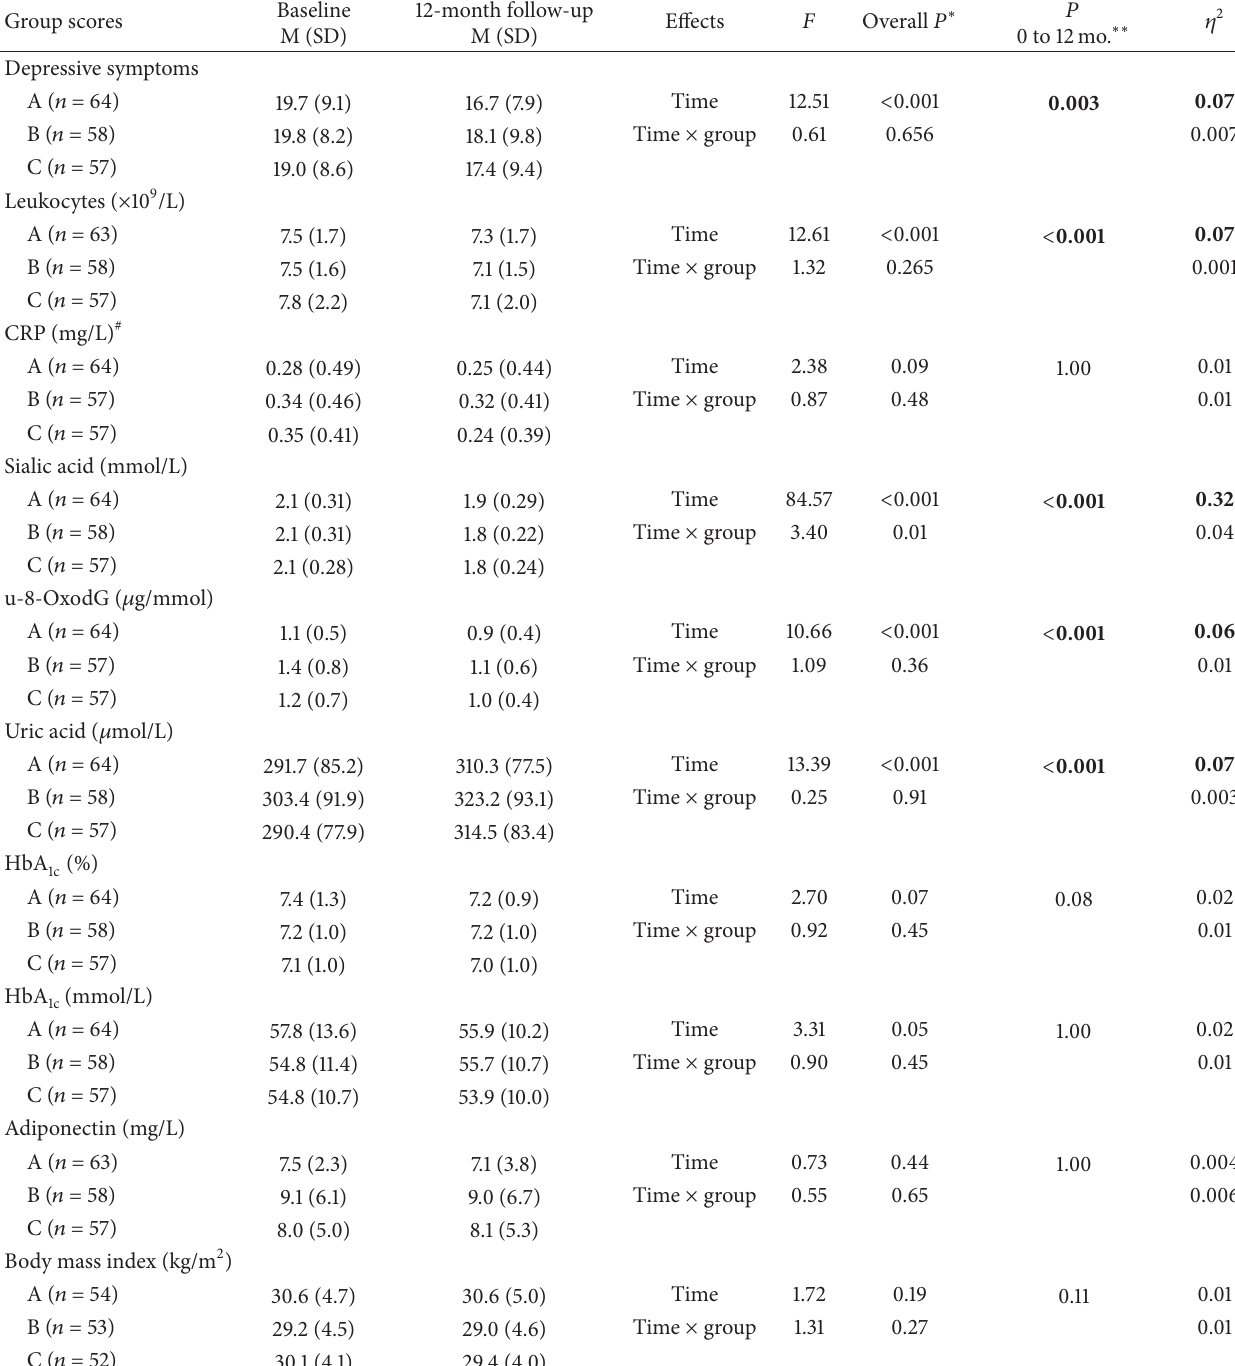
Table 3: One-year changes of depressive symptoms, inflammatory- and prooxidative biomarkers. Group